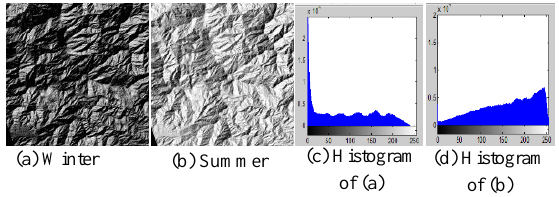
Figure 10. Disparity map generation from winter and summer terrain shading images.